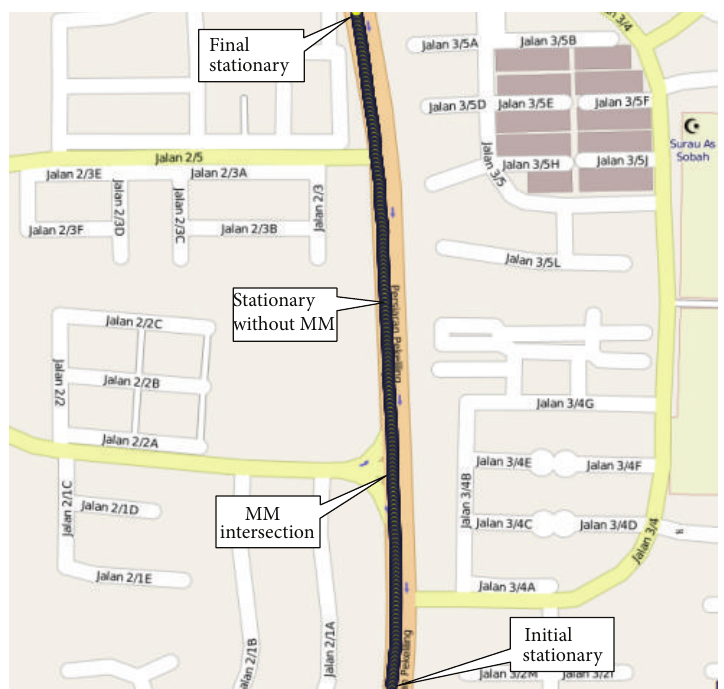
Figure 14: Second test run in Persiaran Pekeliling, Bangi, Selangor, Malaysia, plotted in QGIS.